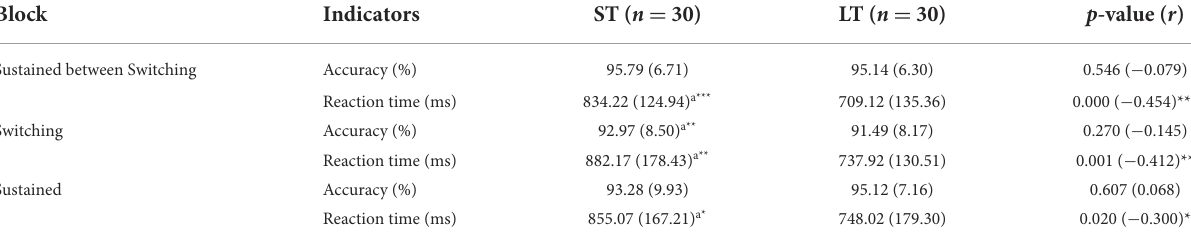
TABLE 5 The accuracy and reaction time of the Switching task in each